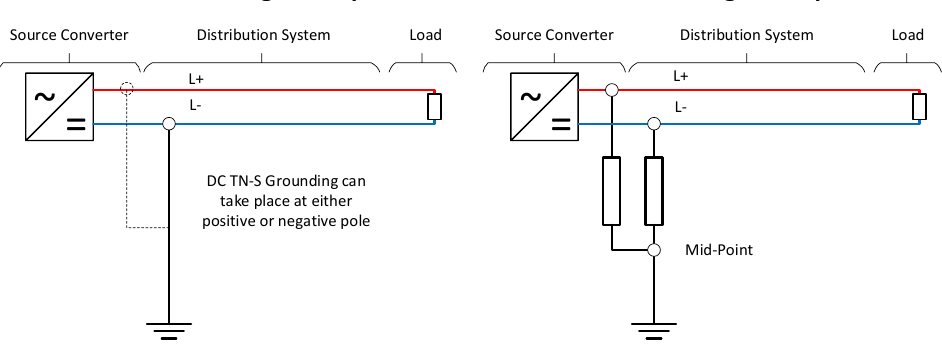
Figure 8. TN-S ( left ) and IT ( right ) Grounding Concepts for DC distribution